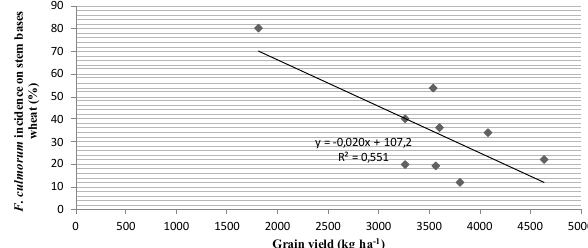
Figure 9. Mean grain yields (kg ha -1 ) of durum wheat harvested after different rotation crops (DW = durum wheat, FB = faba bean, V = vetch), from three demonstration trials at Fernana, Tunisia, during the two cropping seasons 2013/14 and 2014/15.